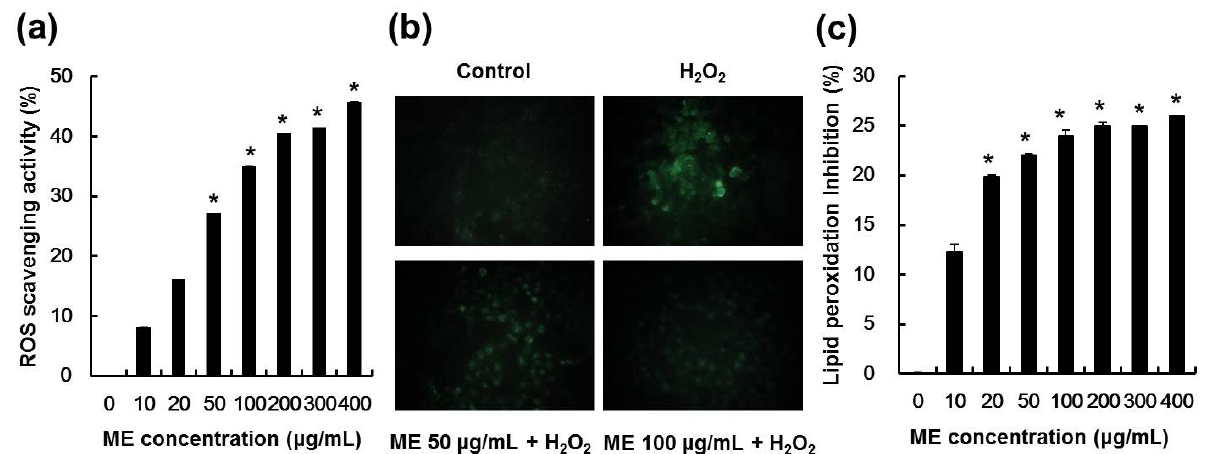
Figure 4. Effect of ME on hydrogen peroxide-induced ROS generation and lipid peroxidation in pancreatic MIN6N cells. ( a ) Intracellular ROS scavenging activity of ME. ( b ) Representative fluorescence images illustrate the increase in green fluorescence intensity of DCF produced by ROS in hydrogen peroxide-treated cells as compared to control and presence of ME. Magnification: 400×. ( c ) Lipid peroxidation inhibitory activity of ME. ( a and c ) Data represent the mean ± SE of three independent